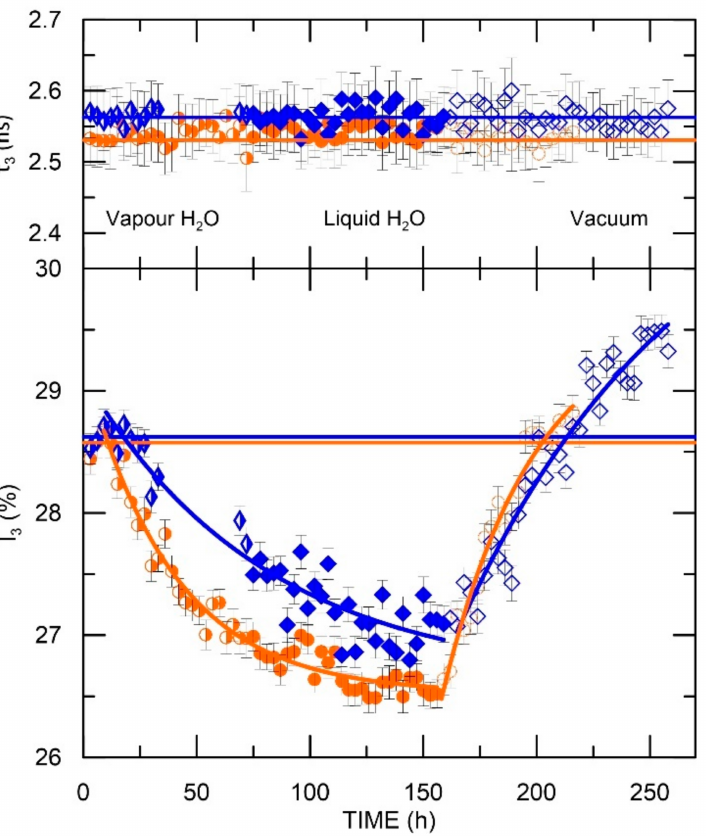
Figure 7. Dependence of o-Ps lifetime and intensity on water presence (ELO/PI—dots, ELO/10RD1/PI—diamonds); half-full points, full points, and empty points represents stage 1, 2, and 3 of measurement regime,